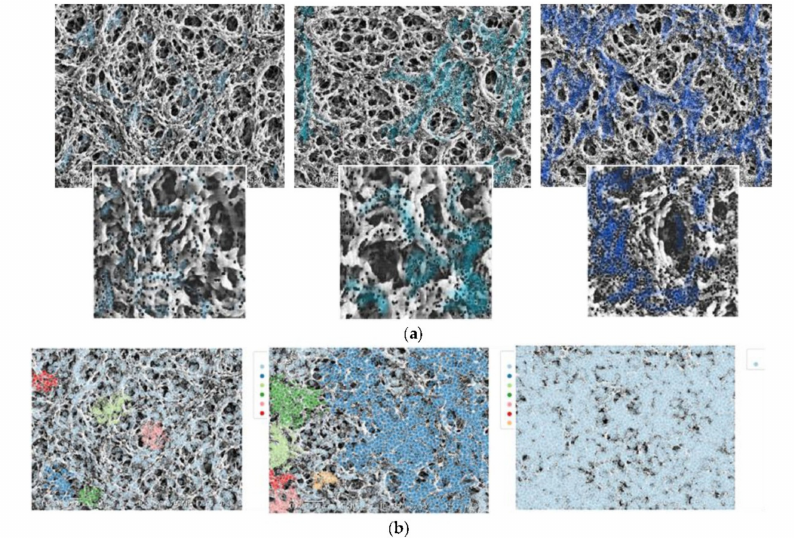
Figure 10. The real and generated images of PVDF flat sheet membranes at feed water concentrations of 2, 5, and 8 mg / L (from left to right)—( a ) highlighted patterns of particle depositions on real (top: 1280 × 960 pixels) and generated images (bottom: 200 × 200 pixels), and ( b ) particle clusters on real images identified by density-based spatial clustering of applications with noise